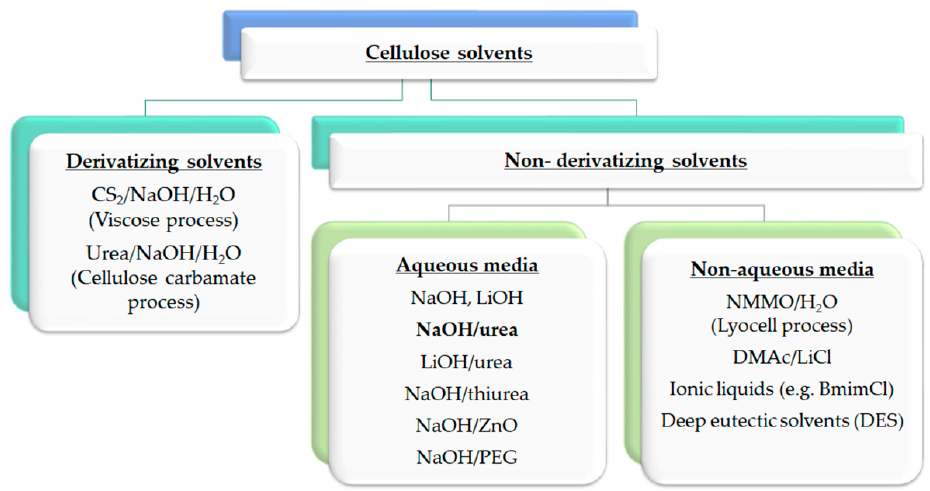
Figure 4. Classification of cellulose solvents. The overview includes the most commonly used and newly researched solvents.